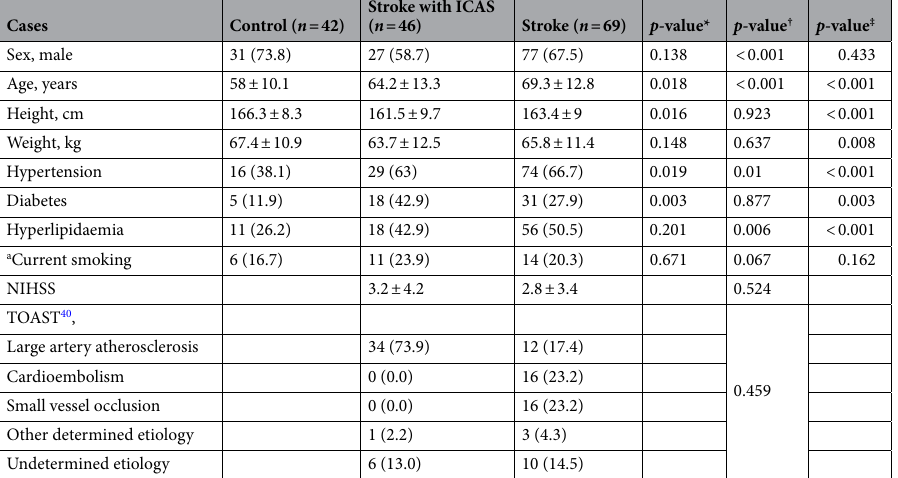
Table 2. Demographic and clinical features of the cohorts ( n = 157). a The intensity of smoking ranges from zero to two. *Boldened if p < 0.05. P‑values statisticalanalysedsed by homoscedastic two-sample t-test had two-tailed distribution parameters between the controls and stroke-with-ICAS patients. † Homoscedastic two- sample t-test had two-tailed distribution parameters between the stroke-with-ICAS and stroke-only patients. ‡ Homoscedastic two-sample t-test had two-tailed distribution parameters between the controls and stroke- only patients. AF, atrial fibrillation; TOAST, Trial of Org 10,172 in Acute Stroke